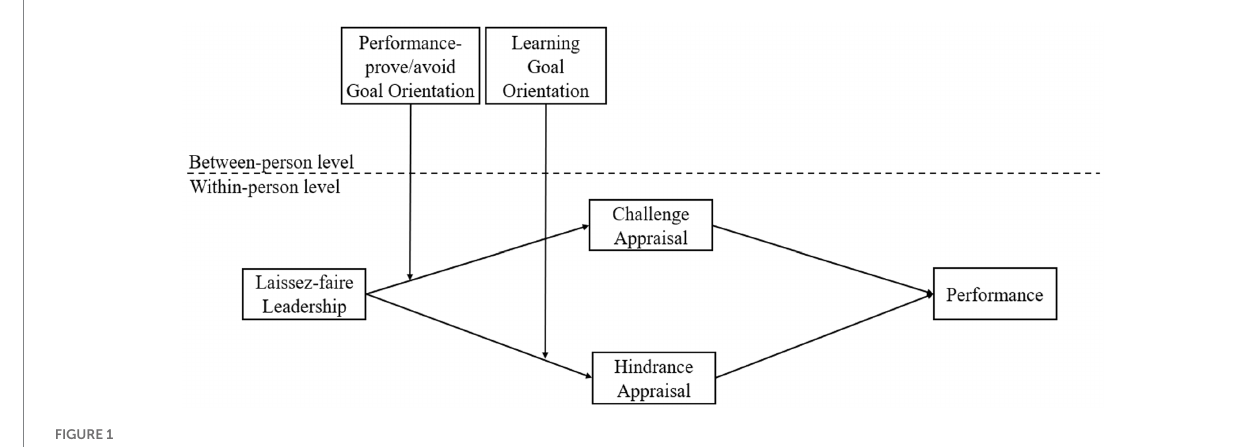
FIGURE 1 Hypothesized